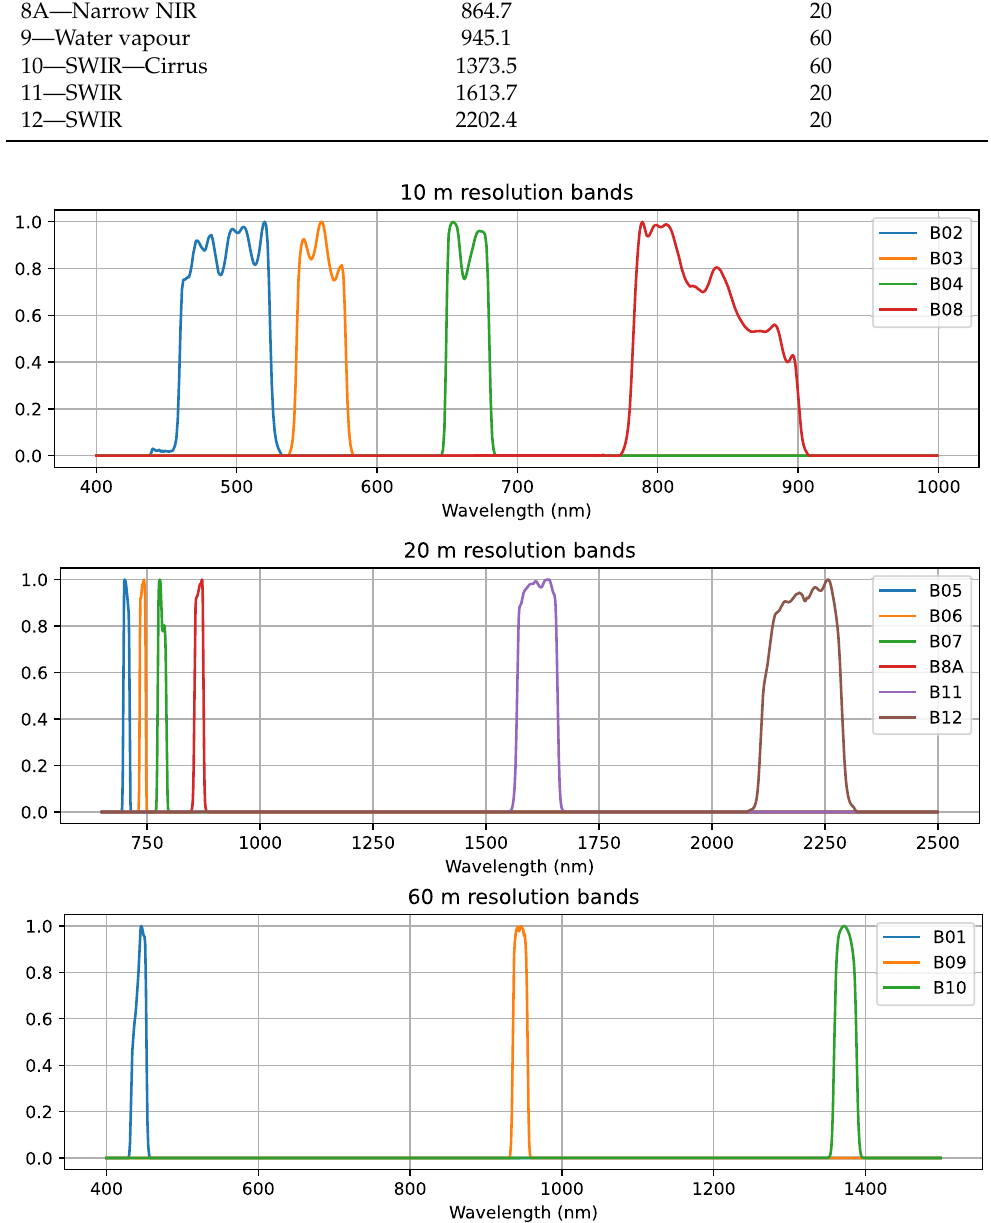
Figure 1. Sentinel-2A relative spectral responses from https://sentinels.copernicus.eu/documents/ 247904/685211/S2-SRF_COPE-GSEG-EOPG-TN-15-0007_3.0.xlsx, accessed on 10 May